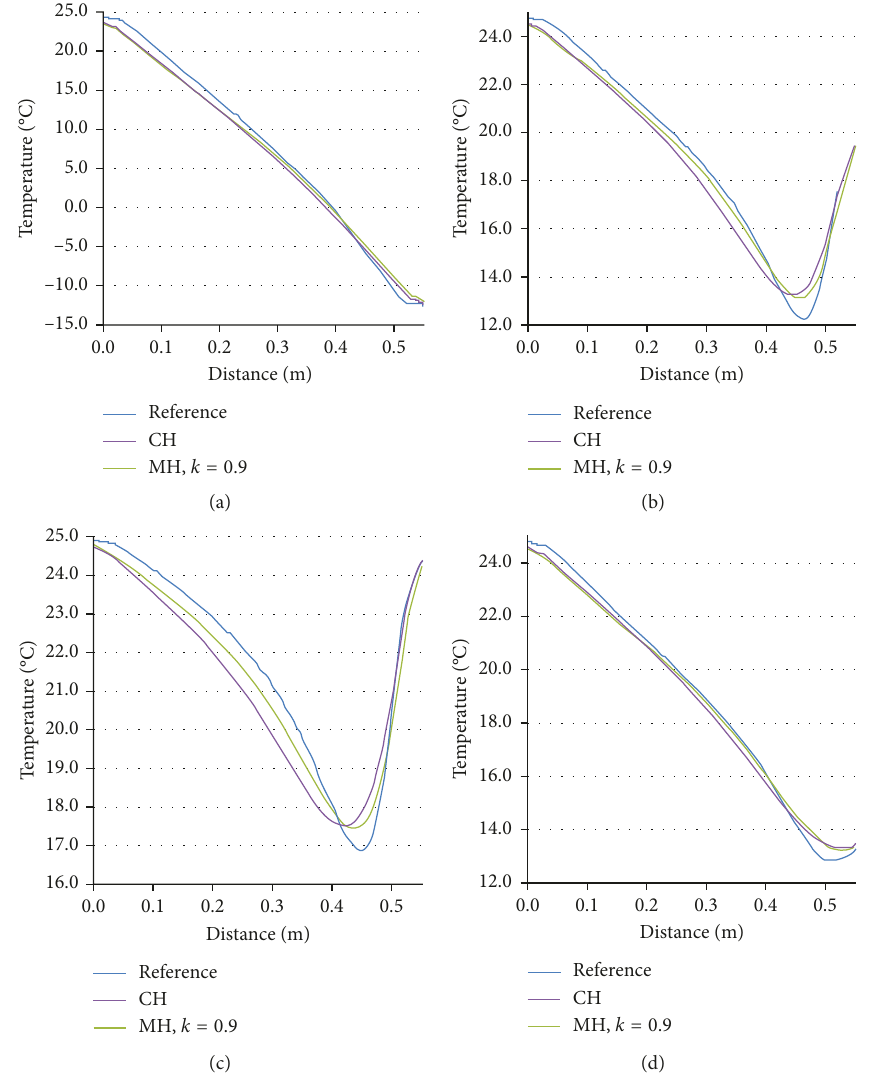
Figure 6: Comparison of temperature profiles: (a) January 15, 12:00, (b) April 15, 12:00, (c) July 15, 12:00, and (d) October 15, 12:00, of the reference